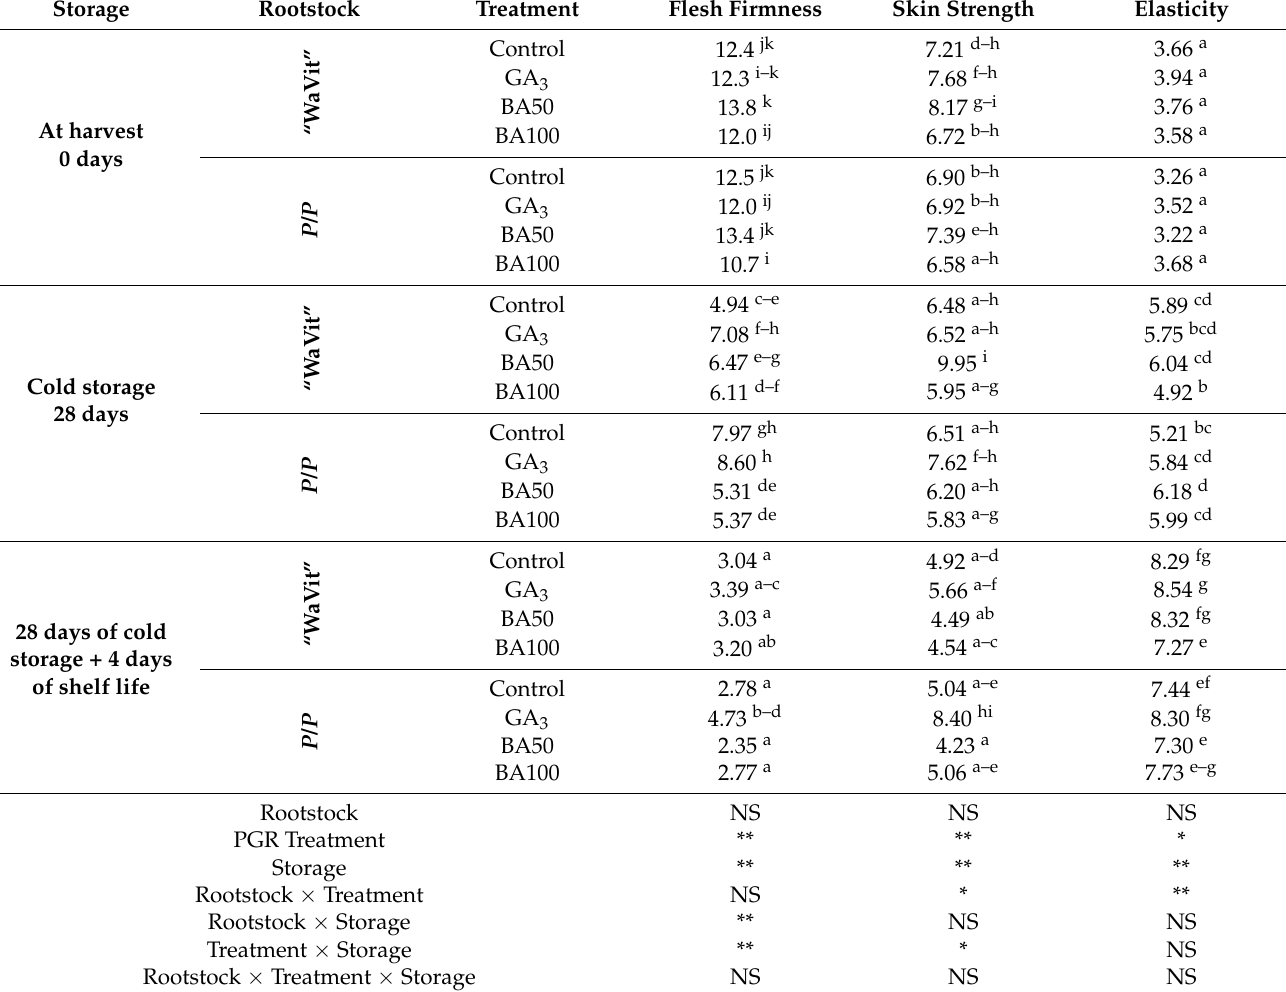
Table 1. Changes in flesh firmness and skin strength, and elasticity of fresh and stored plum grown on two different rootstocks (“WaVit” and P. cerasifera / P. spinosa ) influenced by PGR